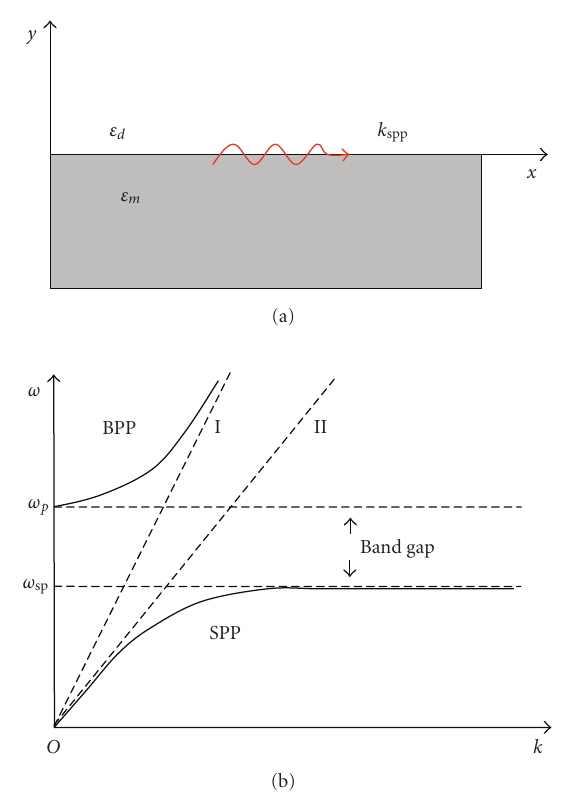
Figure 1: Plasmon-polariton mode associated with the metals: (a) schematic view of infinite metal/dielectric interface; (b) dispersion relation of bulk plasmon-polariton (BPP) and surface plasmon- polariton (SPP) modes. The dashed lines I and II denote the light √ dispersion ω = ck and , ω = ck/ ε d , respectively. The frequency range between ω sp and ω p corresponds to a gap where the electro- magnetic wave cannot propagate via either bulk or surface